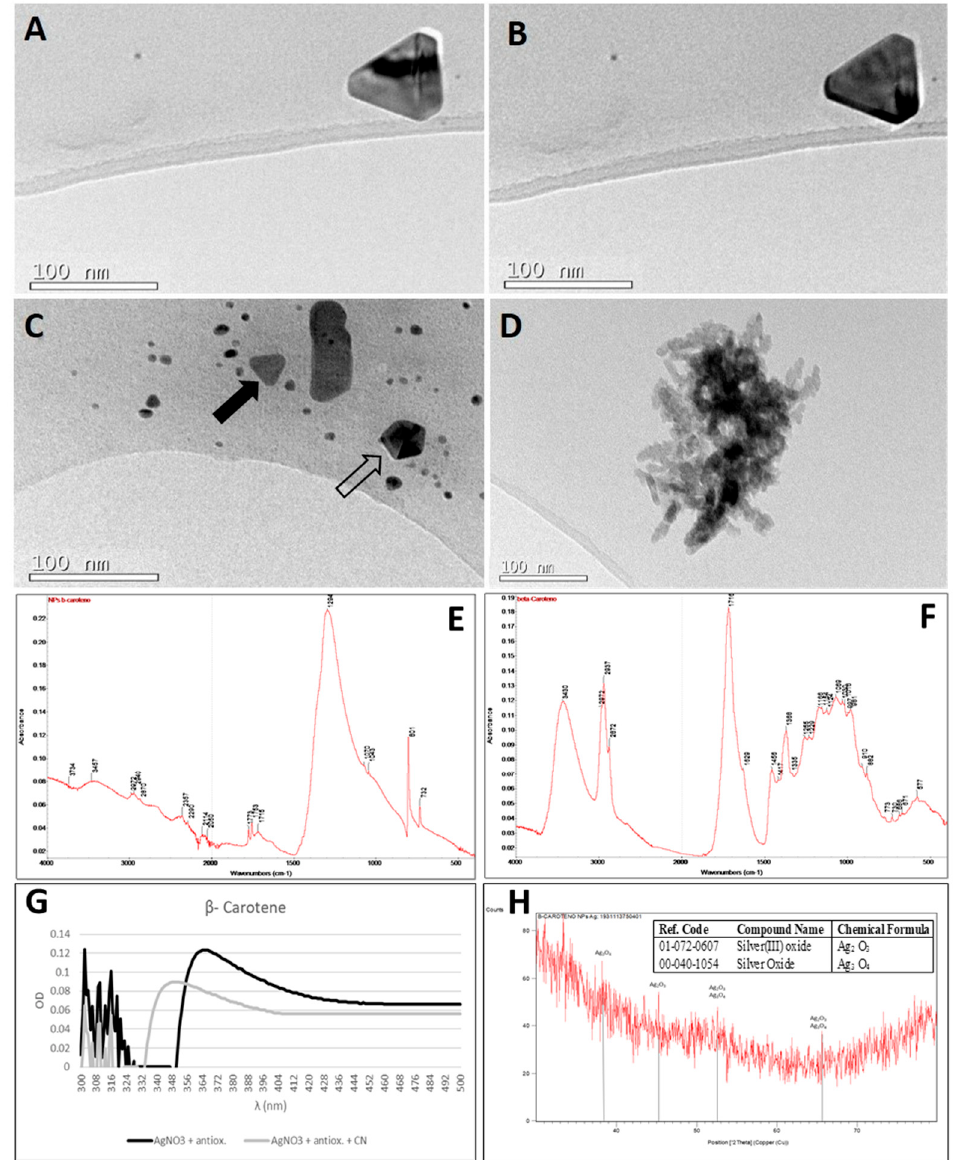
Figure 4. Analysis of the silver nanoparticles synthesised with β -carotene. ( A – D ) images of AgNPs obtained by TEM. ( A , B ) A triangular nanoparticle under two illumination angles, which allows observing its volume. ( C ) Polyhedral shapes (indicated by the hollow arrow) and triangular shapes with truncated vertexes (indicated by the black arrow). ( D ) Polyhedral Amorphous AgNPs after treatment with cyanide. ( E ) Fourier transform infrared (FTIR) spectrum of β -carotene-derived nanoparticles. ( F ) FTIR spectrum of β -carotene. ( G ) Ultraviolet (UV)-visible AgNP spectra prepared with β -carotene and AgNO 3 prior (black line) and after (gray line) cyanide addition. ( H ) X-ray diffraction (XRD) profiles of the AgNPs obtained by the reaction of β -carotene with Ag NO 3 ; in the insert, the table with the identifications. Peaks identifying the presence of silver oxides have been indicated in the XRD diffractogram.